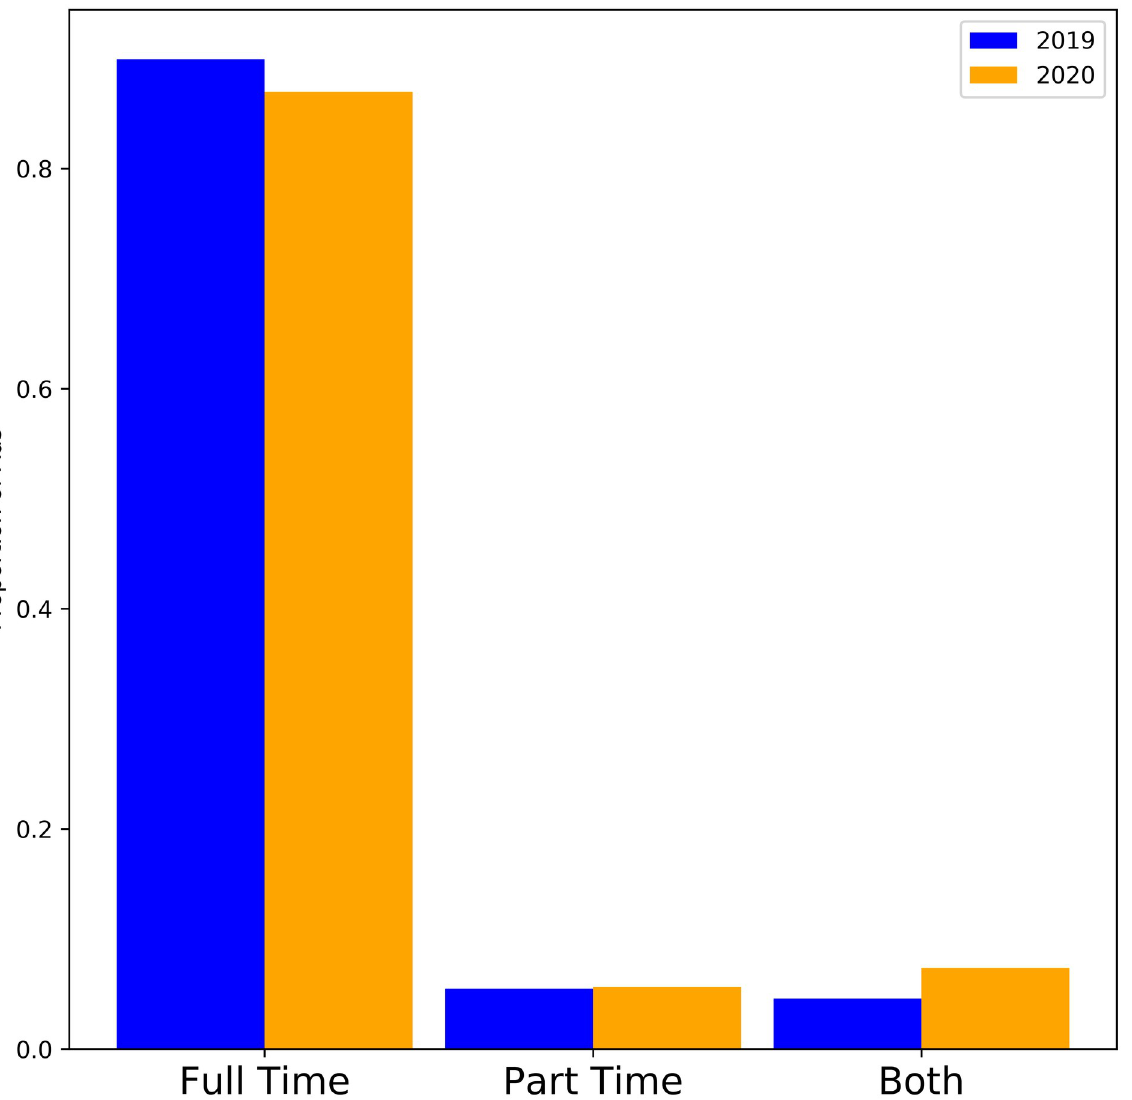
Fig 18. Proportion of job ads corresponding to full time and part time employment. Before Lockdown : Full Time: 90%, Part Time: 5%, Both: 5%. After Lockdown : Full Time: 87%, Part Time: 6%, Both: 7%.